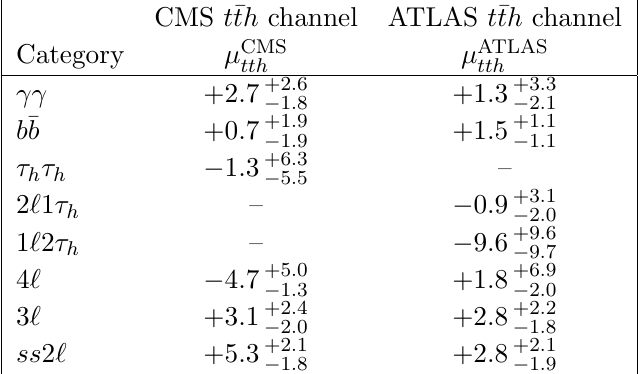
Table 1 . The best-(cid:12)t values for the category-dependent signal strengths (cid:22) CMS from the CMS [11] and ATLAS [20, 46, 47] searches, respectively, for the associated production of the Higgs boson with a top quark pair at